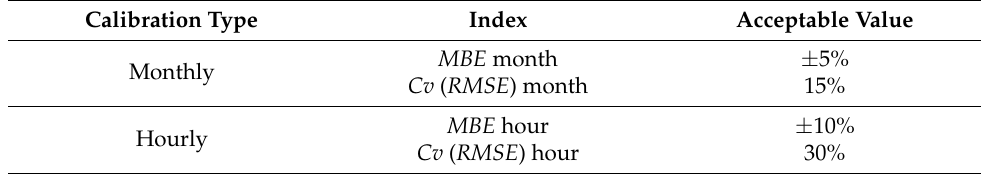
Table 9. ASHRAE Guideline